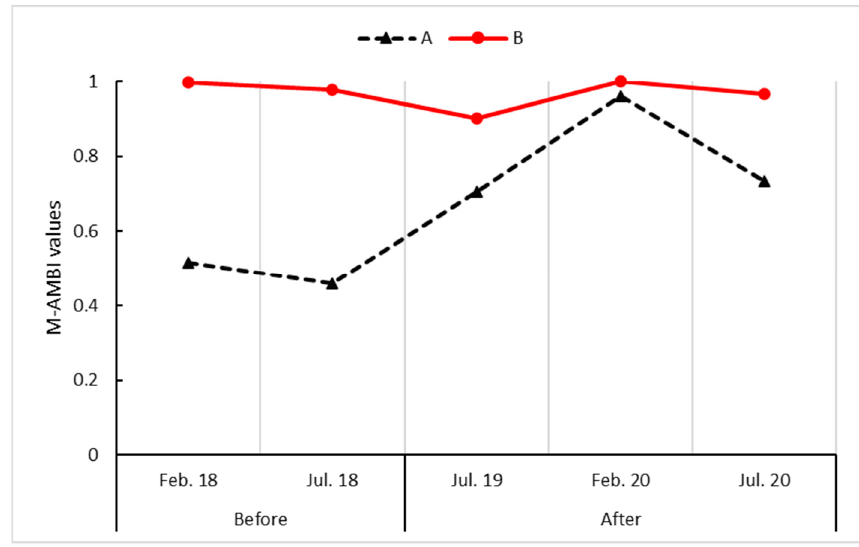
Figure 5. M-AMBI values from 2018 to 2020 of the Treatment (A) and the Control (B) sites, before and after the conversion of the plant. Table 3. PERMANOVA on benthic assemblages of Treatment and Control sites at Before (T1, T2) and three After (T3–T5) the bioremediating action. Abundances of taxa were square root transformed.